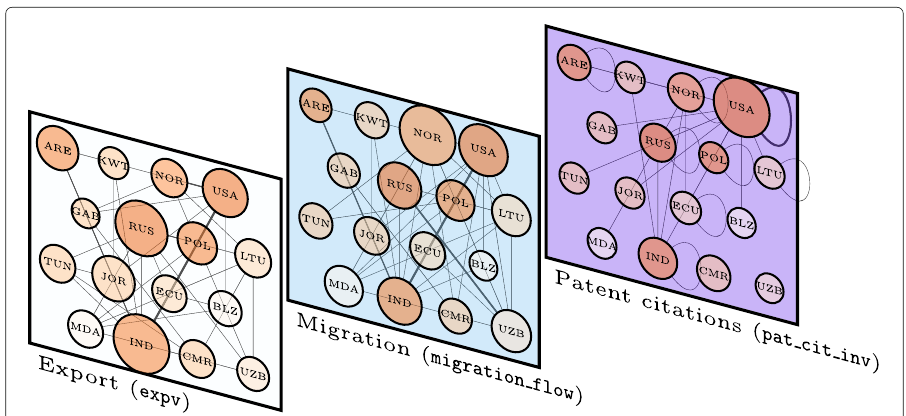
Fig. 2 Subset of the international multiplex. Four nodes have been selected from each of the pcGDP quartiles. Node size is proportional to node degree in the whole layer, node color intensity is proportional to MultiRank centrality in the whole multiplex, edge width is proportional to edge